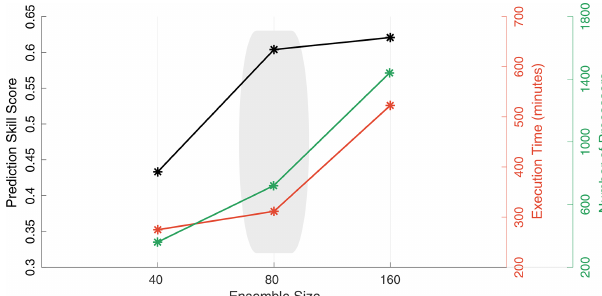
Figure A1. Prediction skill score (PSS; in black) obtained for three different WRF-Hydro and DART assimilation experiments where the ensemble size is varied, namely N e = 40 , 80 , and 160 mem- bers. Also plotted as function of the ensemble size is the experiment execution time (right red axis) and the total number of processors needed to run the experiments (right green axis). The shaded region indicates the optimal ensemble size configuration we select in this study. PSS is computed as follows: 1 − MSE DA / MSE REF , where MSE denotes mean squared errors, DA means a data assimilation run, and REF is a reference run (the open loop in this